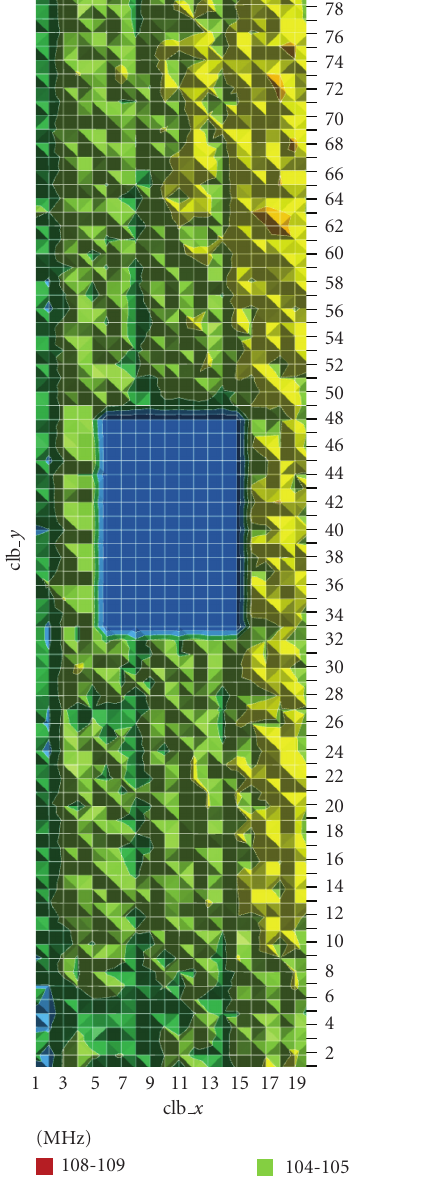
Figure 13: OSC frequency map (MHz) board 5.